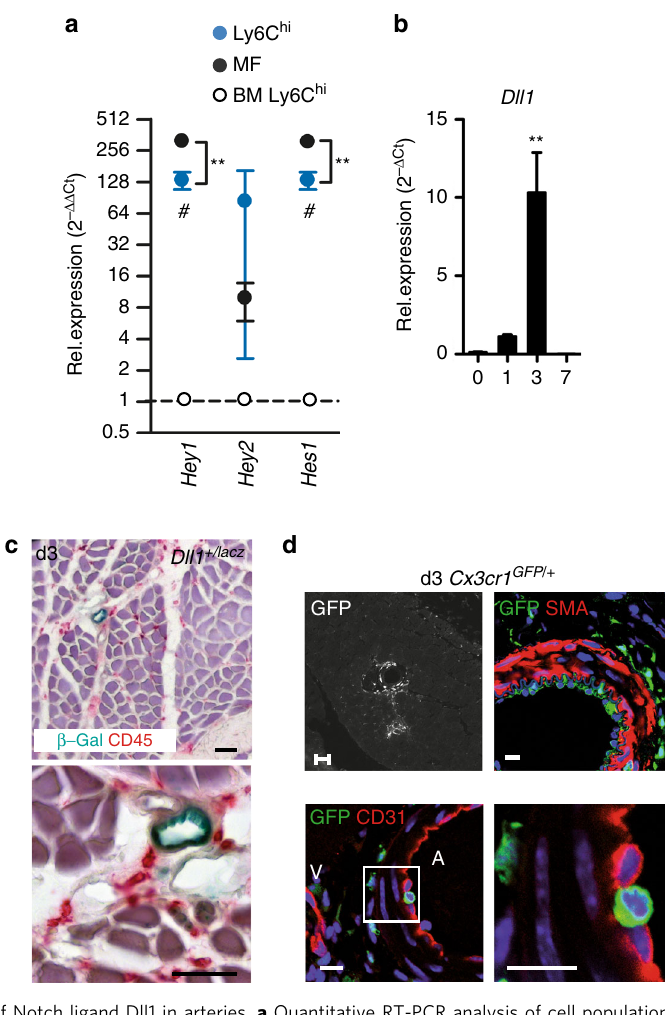
Fig. 2 Ischemia triggers induction of Notch ligand Dll1 in arteries. a Quantitative RT-PCR analysis of cell populations of Cx3cr1 GFP/ + mice sorted from d3 ischemic muscle relative to bone marrow (BM) Ly6C hi monocytes. n = 3 independent experiments, error bars represent s.e.m. *** p < 0.001, ** p < 0.01, * p < 0.05 # Comparison between muscle and BM Ly6C hi cells, *Comparison between muscle Ly6C hi and macrophages (MF), One way ANOVA with Bonferroni multiple comparison post-test b Quantitative RT-PCR analysis of ischemic muscle at indicated time points d . n = 3/4/4/4 mice/group, error bars represent s.e.m., one way ANOVA with Dunnett's Multiple Comparison test. c β -galactosidase activity (blue) and CD45 immunohistochemistry (red) in ischemic muscle from Dll1 + /lacZ reporter mice. Scale bars = 50 µ m. d Representative immunostaining and confocal microscopy of collateral arteries in Cx3cr1 GFP/ + mice after HLI. Phase contrast image (GFP) × 5, scale bar = 200 µ m. Confocal images with anti-SMA × 40, CD31 × 40 and × 63. Nuclear counterstain (DAPI, blue). Scale bar = 20